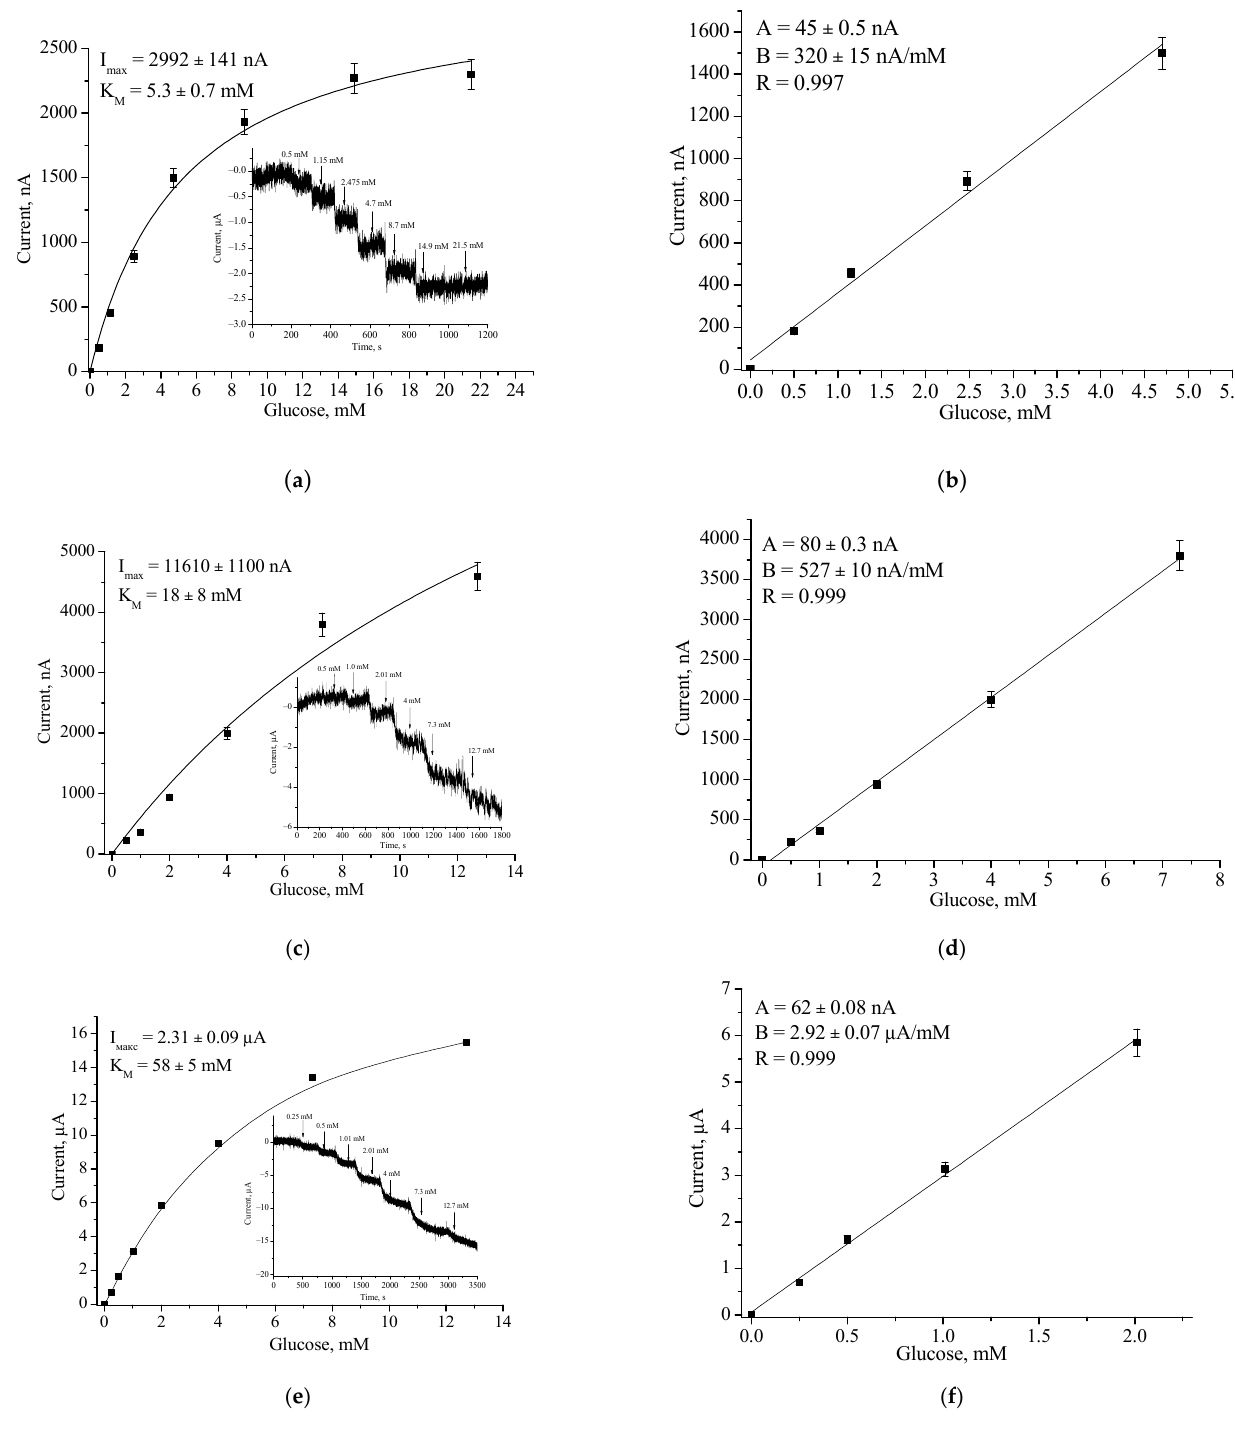
Figure 4. Amperometric characteristics of the GO/PO/GE ( a , b ), GO/nCuCe/GE ( c , d ), and GO/nCuCe/pAu/GE ( e , f ): ( a , c , e ) chronoamperograms (inserted) and dependence of amperometric signal on concentration of glucose; ( b , d , f ) calibration graphs for glucose determination. Conditions: working potential –50 mV vs. Ag/AgCl/3 M KCl in 50 mM PB, pH 6.0. The sensing layers contained 0.01 U of PO/PO-like activity and 0.01 U of GO.